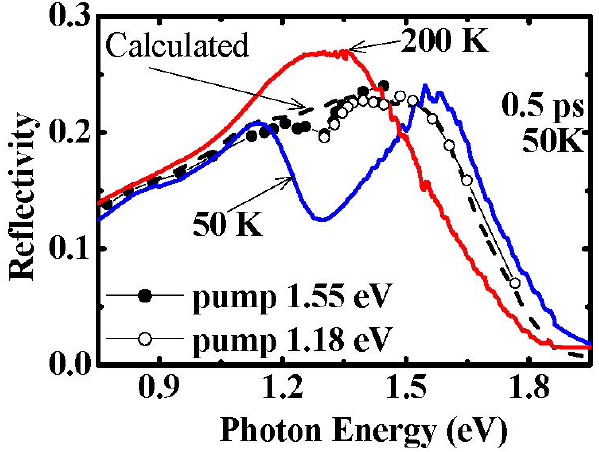
Figure 3. Closed and open circles correspond to photoinduced reflectivity spectra ( E || a -axis) with excitation photon energies of 1.55 eV and 1.18 eV, at 0.5 ps after photo-irradiation. Excitation intensity, i.e. , number of absorbed photons per unit volume estimated by considering penetration depth of excitation light, was 1.4 × 10 20 photons/cm 3 at 1.55-eV pump and 7.6 × 10 19 photons/cm 3 at 1.18-eV pump. Solid lines plot spectra without photoexcitation at 50 K (blue, CS phase) and 200 K (red, DM phase). Dashed line plots the simulated reflectivity spectrum using multi-layer model [27]. Reproduced with permission from Ishikawa et al . [28]. Copyright (2009) by the American Physical